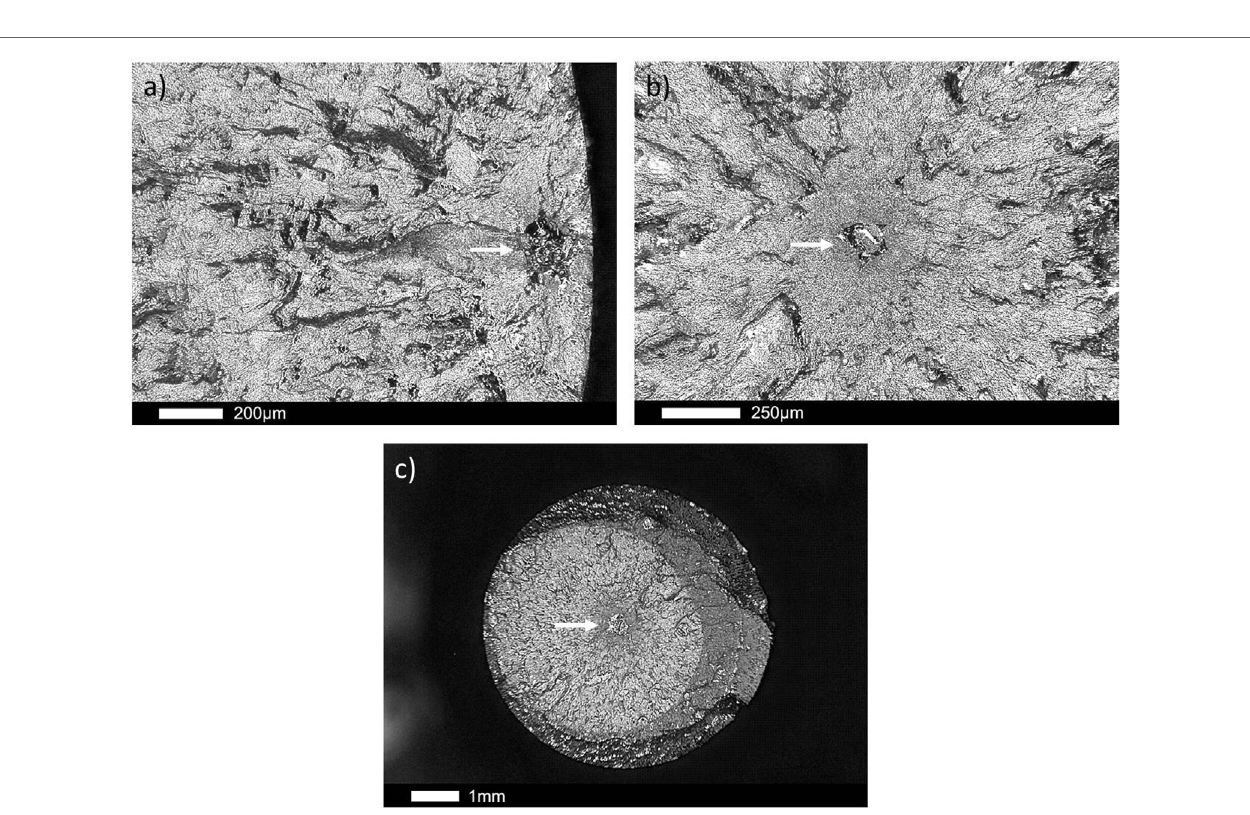
FigUre 3 | crack initiation at process inherent defects for stress-relieved specimen under tension–compression loading; defect with (a) and without (B,c) surface interaction .